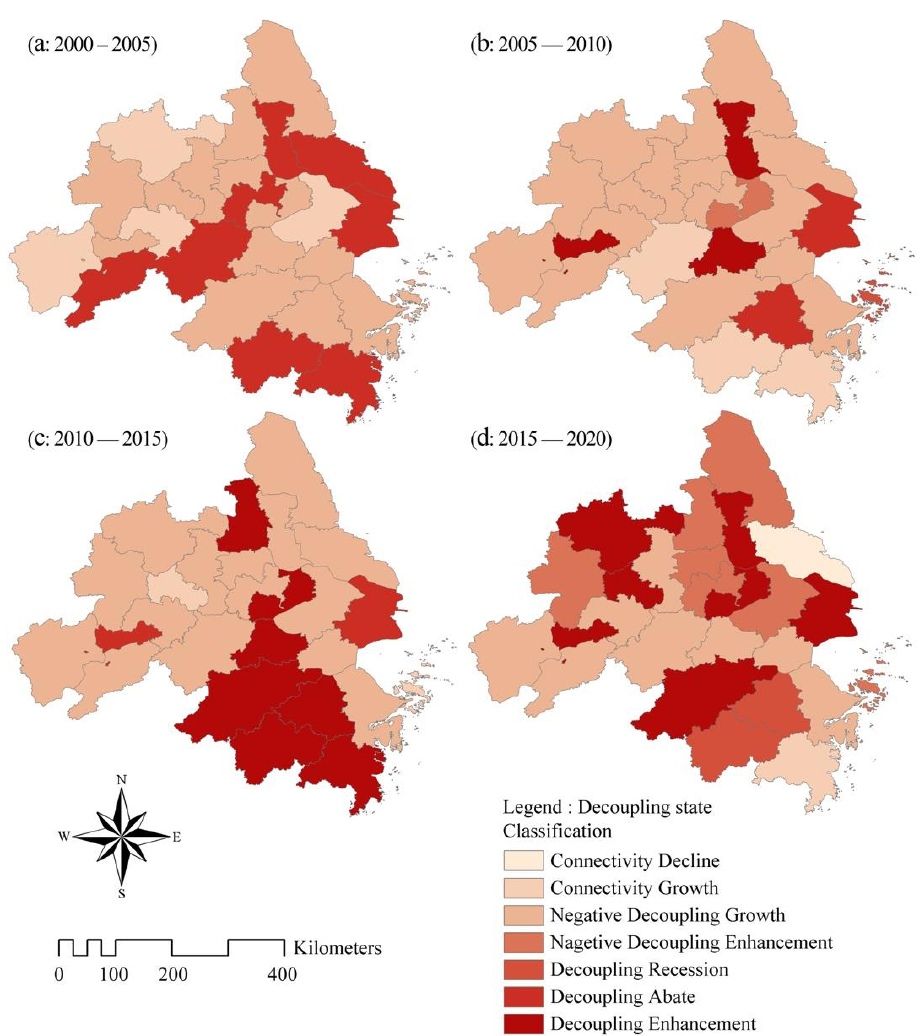
Figure 7. Spatial distribution characteristics of decoupling between CEEC and gross industrial out-put value of prefecture-level cities in the YRD.